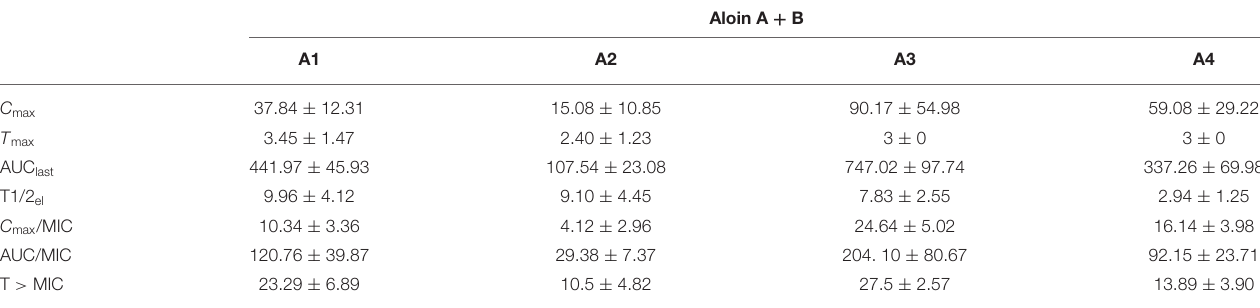
TABLE 4 | Mean ± SD ( n = 20 per groups A1, A2, and A3 and n = 19 per group A4) for the pharmacokinetic parameters and therapeutic efficacy indices of aloin A + B (AB) detected in cow milk for each intramammary formulation of Aloe vera combined with cloxacillin or ceftiofur, after a single dose. Aloin A + B